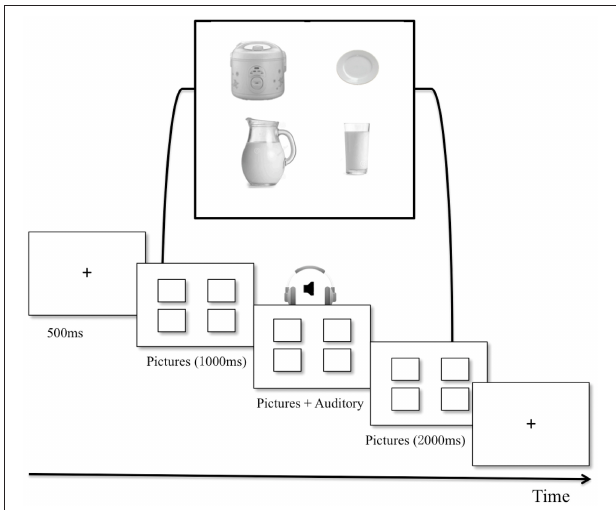
FIGURE 1 | Procedure and sample visual materials used in Experiments 1 and